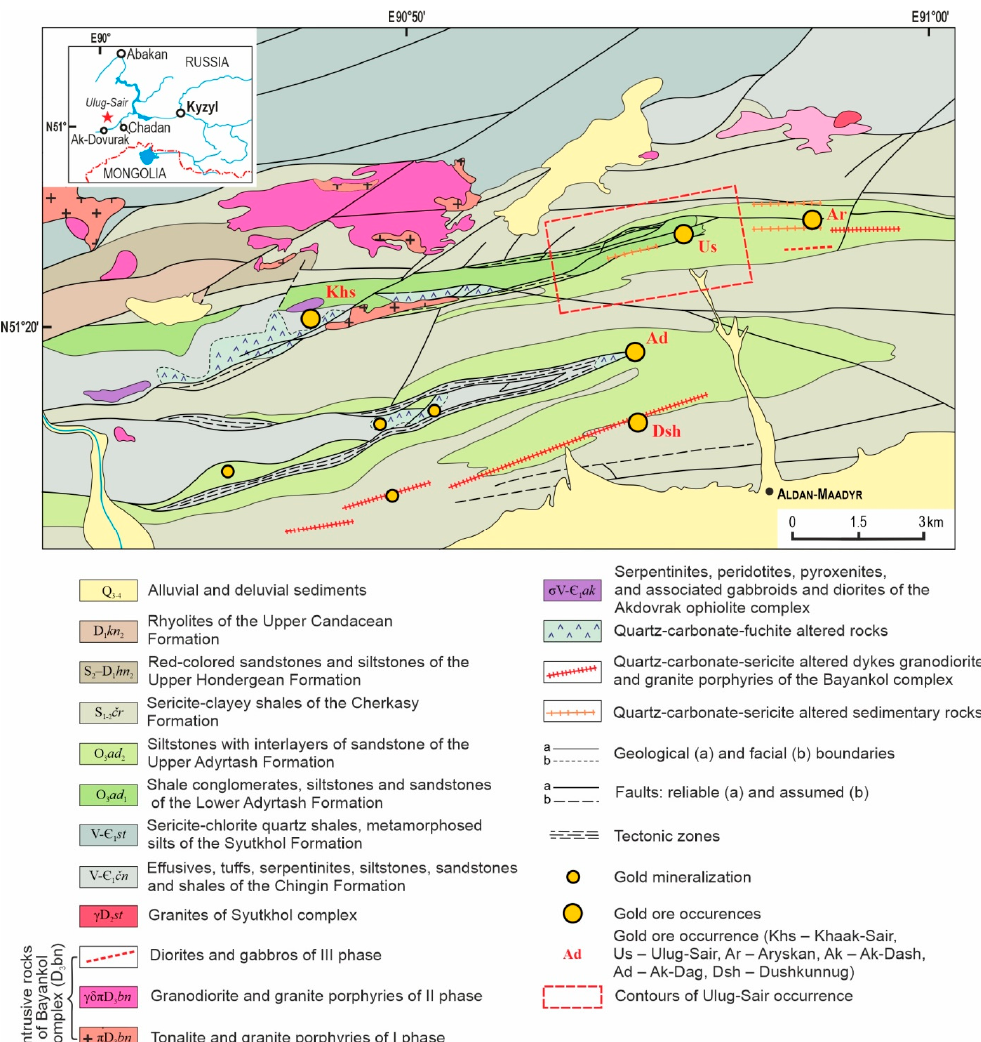
Figure 1. Geological scheme of the central part of Aldan-Maadyr ore cluster, simplified with permission from [29]. The Aldan-Maadyr ore cluster is located on the left bank of the Khemchik River and is related to the junction zone of: (a) Early Cambrian–Ordovician terrigenous complexes of the Western Sayany; (b) Vendian–Early Cambrian oceanic complexes and Middle Cam- brian–Silurian molasses, which, respectively, formed the basement and sedimentary cover of the Khemchik–Systygkhem pre-arc collision; and (c) Devonian magmatic and sedimen- tary complexes of one of the “branches” of the Tuva riftogenic trough [31]. Gold mineralization is controlled by narrow, linear, near NS anticlines and horst an- ticlines and the associated fractures of the Sayany-Tuva deep fault of the same orientation cutting them. A similar orientation of the main discontinuous and folded structures led to a linear distribution of igneous rocks and narrow linear quartz–sericite–fuchite–carbonate alteration zones with gold–quartz veins.